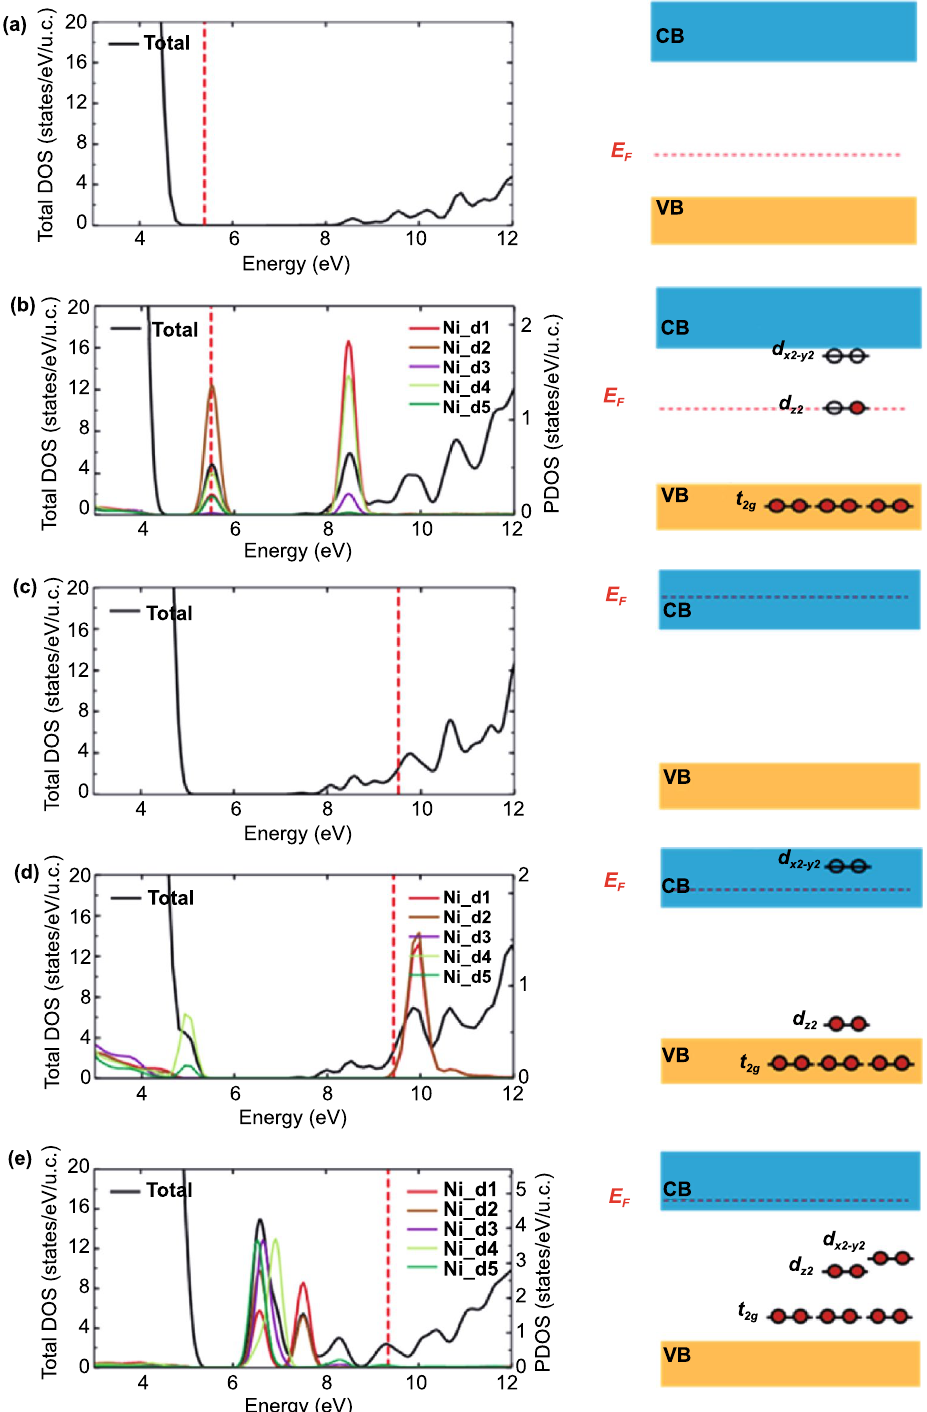
Ni atom (left panels) and schematics for defect levels (right panels) for c Ref. ITO, d ITO with a substitutional Ni In defect, and e ITO with an interstitial Ni In